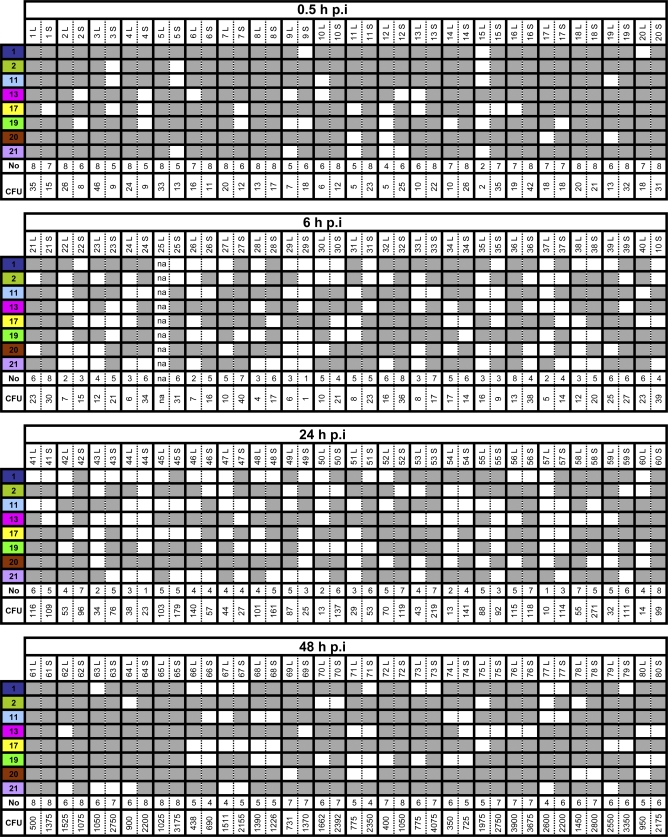
Presence and Absence of WITS in Individual MiceWITS presence (grey box), or absence (white box) in the liver (L) or spleen (S) of individual mice (n = 20 per time point) at 0.5, 6, 24, and 48 h p.i. The individual WITS are indicated by coloured boxes (dark blue = WITS 1, olive green = WITS 2, light blue = WITS 11, pink = WITS 13, yellow = WITS 17, bright green = WITS 19, brown = WITS 20, and lavender = WITS 21). In addition, the number of WITS (No) and CFU (CFU) in each organ are indicated.